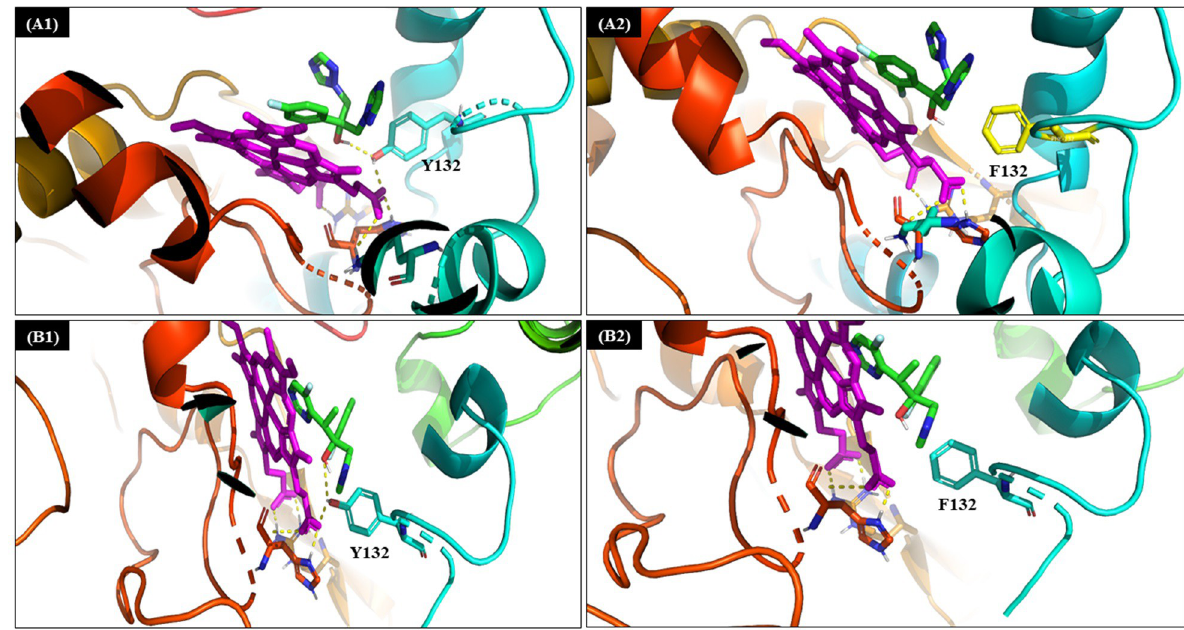
Fig 4. Docked pose and interacting residues of (A1) wild protein with Tyrosine132 (cyan) H-binding to Heme (purple) and Fluconazole (green) (A2) mutated protein with Phenylalanine 132 (yellow) in presence of Heme (purple) and fluconazole (green) displays no H-bonding (B1) wild protein with H-bonding of Tyrosine 132 with Heme (purple) and Voriconazole (green) (B2) mutated protein with no H-bonding of Phenylalanine in presence of Heme (purple) and Voriconazole (green). For clarity, only selected binding site residues are shown.